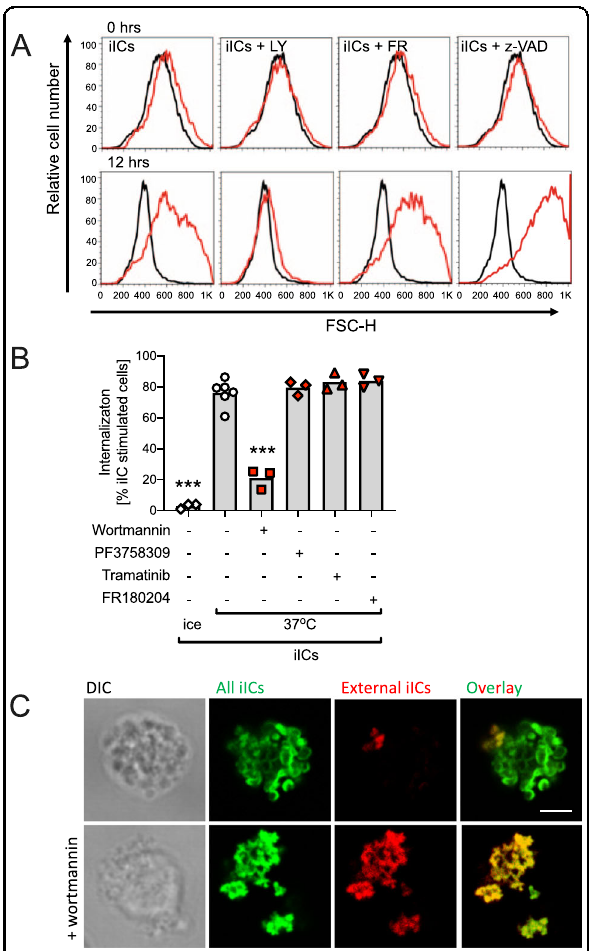
Fig. 2 Neutrophils internalize iICs in a PI3K-dependent fashion. Neutrophils were pre-incubated with small molecule inhibitors or vehicle (LY, LY274002, wortmannin, pan-PI3K inhibitors; FR, FR180204; z-VAD, z-VAD-FMK; PF3758309, Pak inhibitor; Tramatinib, Mek inhibitor) at 37 °C for 10 min and stimulated with 10 μ g/ml iICs (HSA anti-HSA) in IMDM supplemented with 10% autologous serum and cultured at 37 °C. A Singlets were gated and analyzed by fl ow cytometry at the indicated times. Representative forward scatter histograms are plotted. For ease of viewing, plots of vehicle-treated cells obtained at the indicated times (black) are shown in all iIC-stimulated conditions (red). A representative example is shown of ≥ 3 independent experiments performed. ( B + C ) Following vehicle or inhibitor treatment, neutrophils were stimulated for 30 min with ( B ) AF488-labelled iICs on ice or at 37 °C in suspension. Neutrophils were then placed on ice and